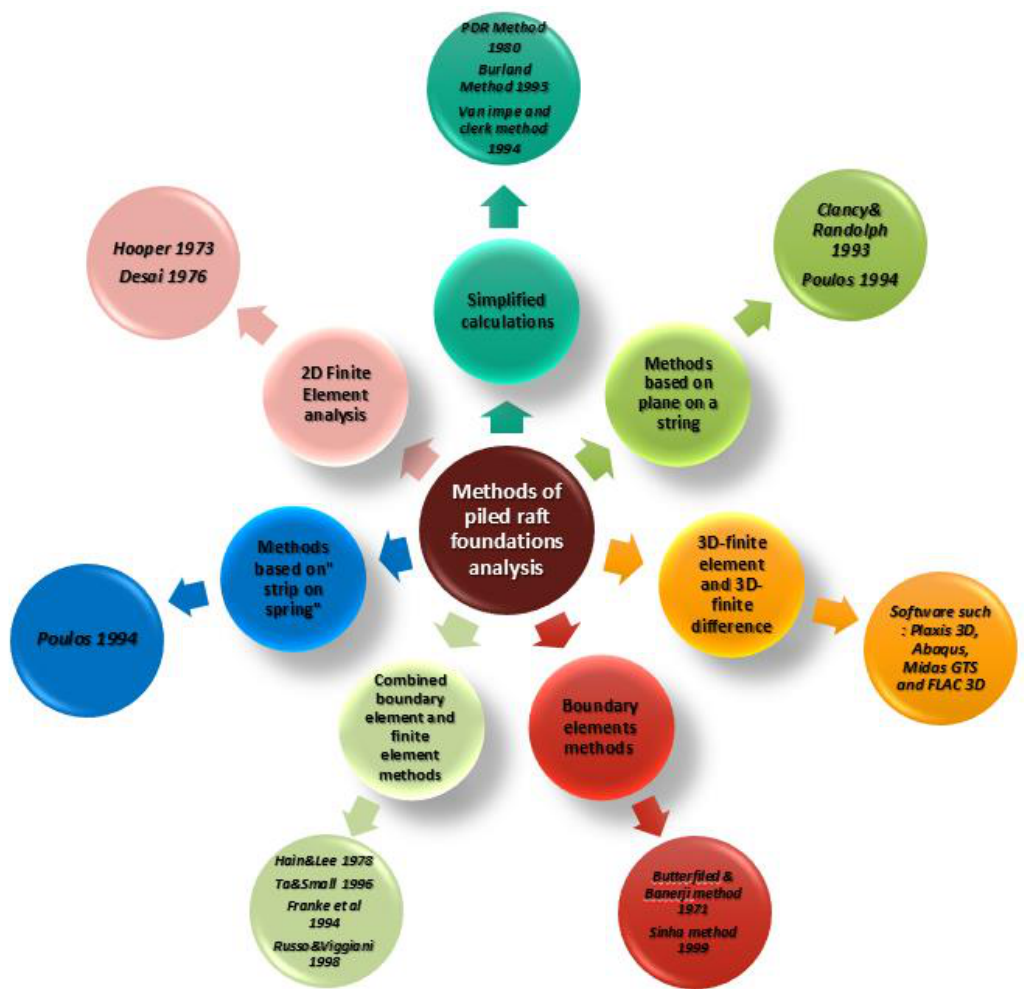
Fig. 2. Summary of the different methods of piled raft foundation